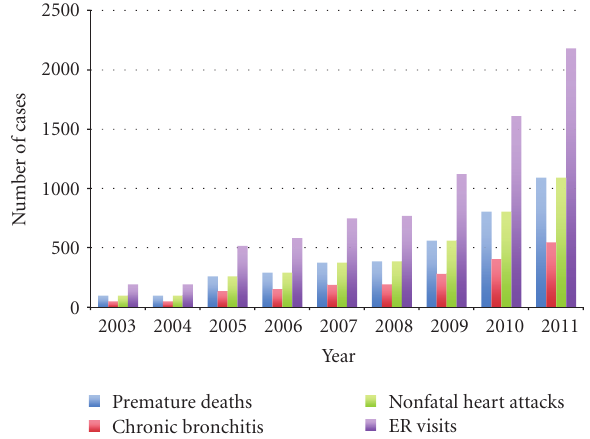
F 7: Potential market value of pollution